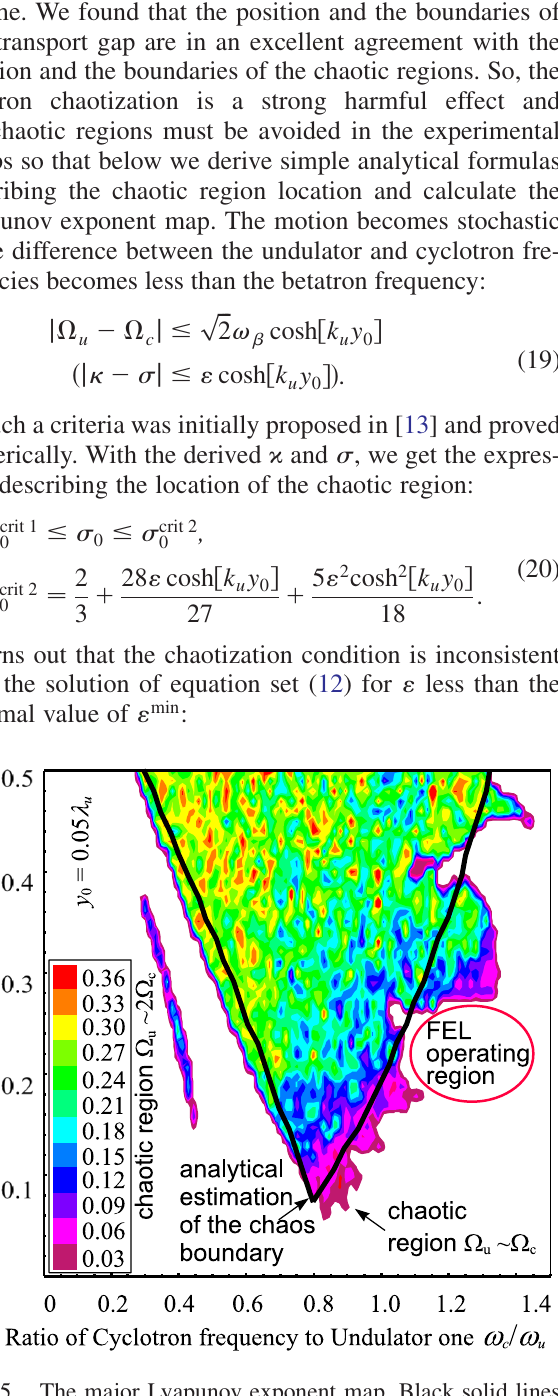
FIG. 5. The major Lyapunov exponent map. Black solid lines show the boundaries of the chaotic region according to the analytical formulas